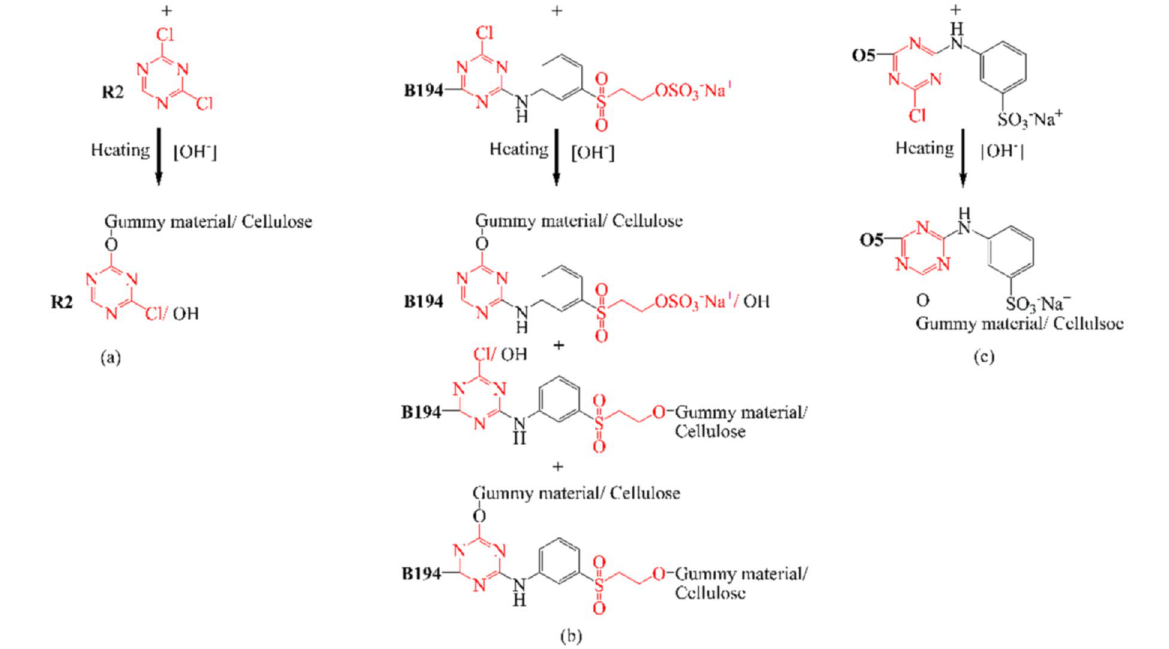
Figure 3. Interaction of grass cloth with the functional sites of R2 ( a ), B194 ( b ), and O5 ( c